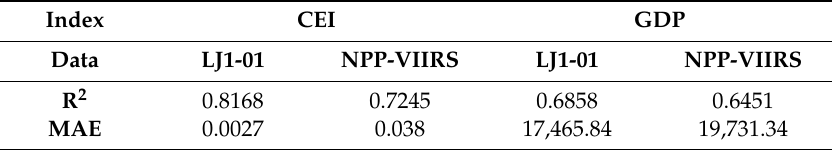
Table 8. Comparison of the accuracy for the RF model to regress CEI and